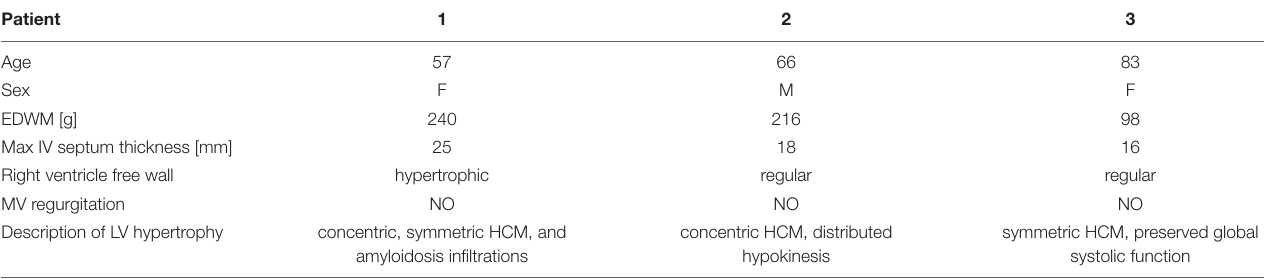
TABLE 1 | Main characteristics of the HCM patients